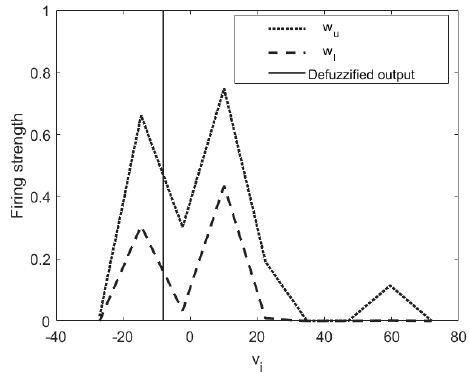
Figure 7. Type-2 Sugeno fuzzy output aggregated set for a particular estimation.